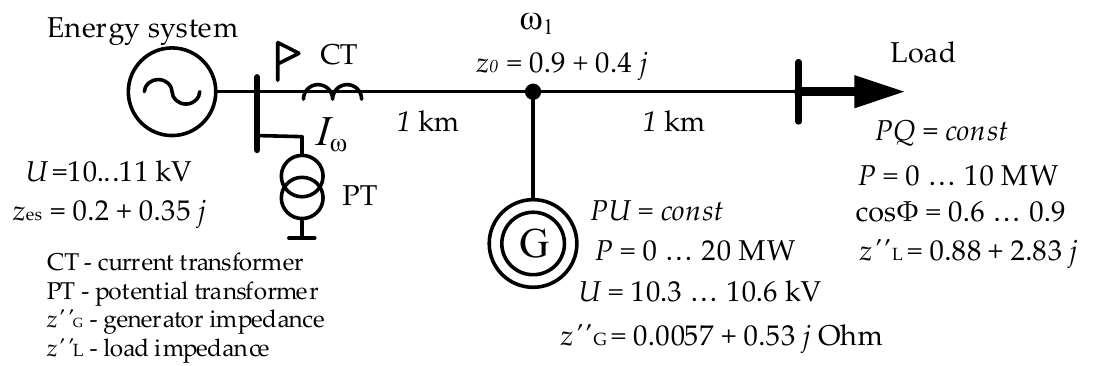
Figure 2. Scheme of the protected section of the network.